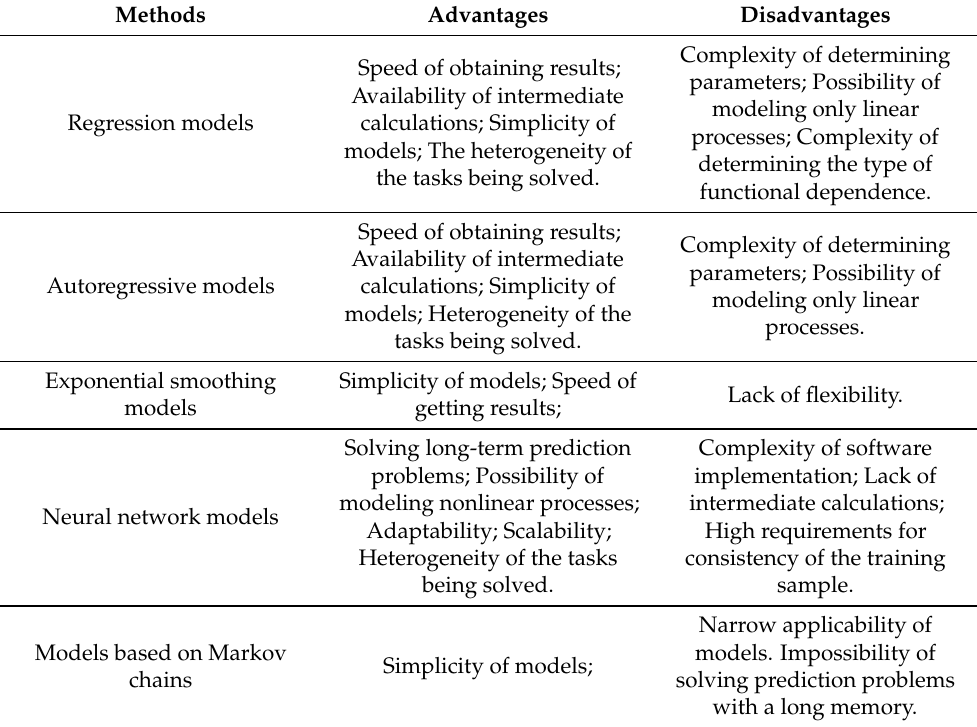
Table 3. Summary of advantages and disadvantages of prediction